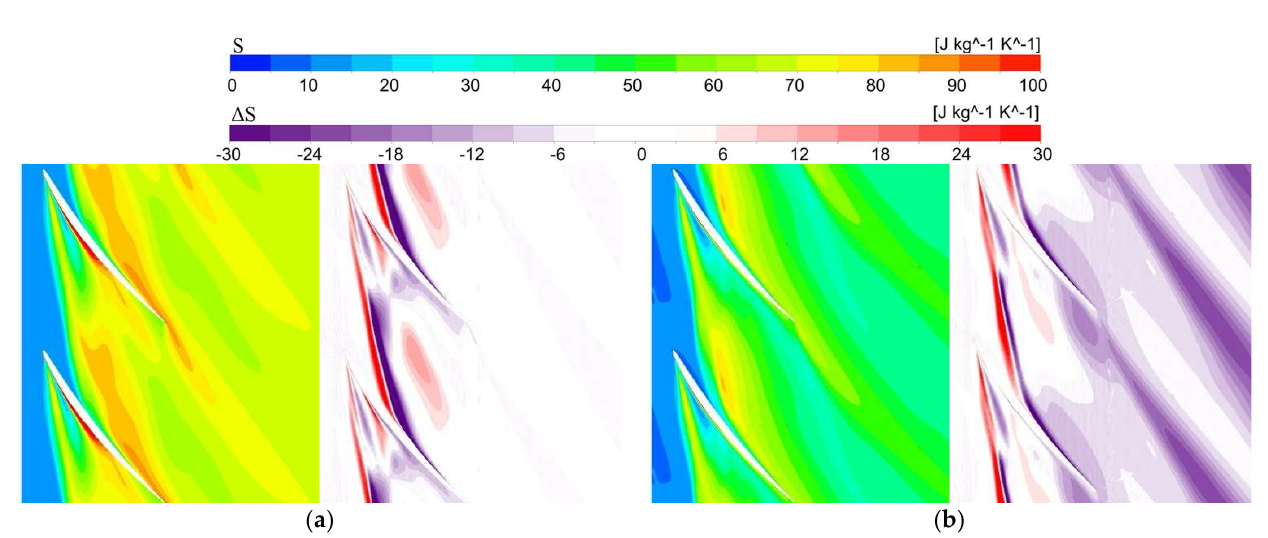
Figure 17. Entropy distribution with wake and its difference with no wake at 99% span. ( a ) Re = 1 × 10 5 ; ( b ) Re = 4 × 10 5 .